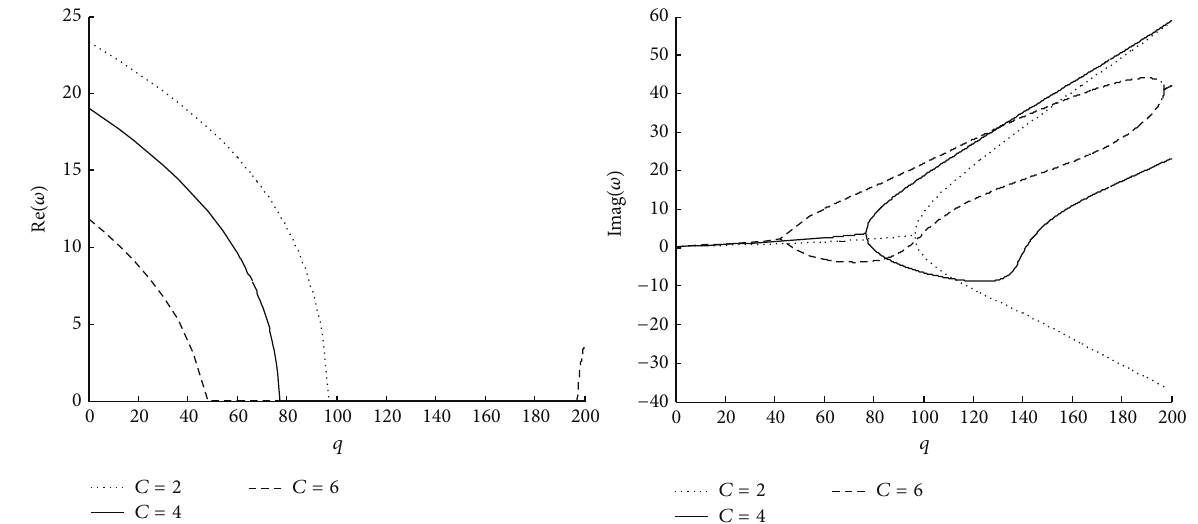
Figure 5: The first-order dimensionless complex frequencies versus dimensionless follower force 𝑞 ( 𝐻 = 10 −3 , 𝑟 = 1 , 𝑈 = 10 , and 𝜆 = 0.05